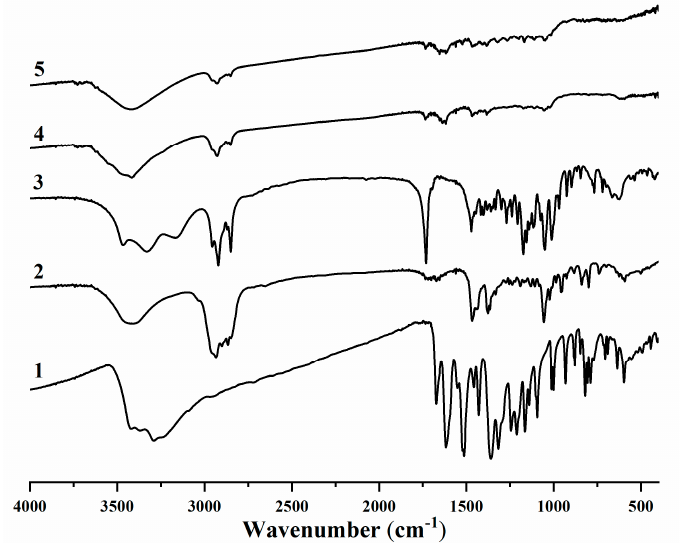
Figure 4. FTIR spectra of quercetin (1), cholesterol (2), glucose monolaurate (3), plain niosomes (4) and quercetin-loaded niosomes (5).